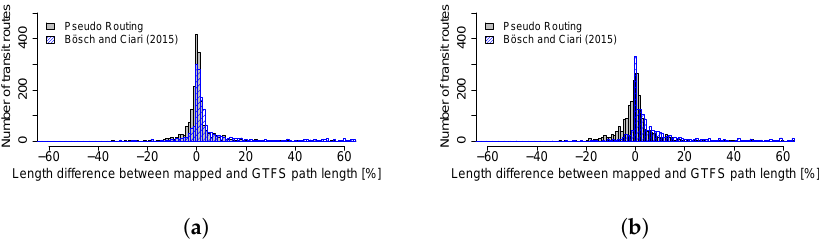
Figure 10. Histogram showing the number of transit routes for length differences in percent between the mapped transit path length and length of the corresponding GTFS path. ( a ) mapping with stop locations; ( b ) mapping with parent